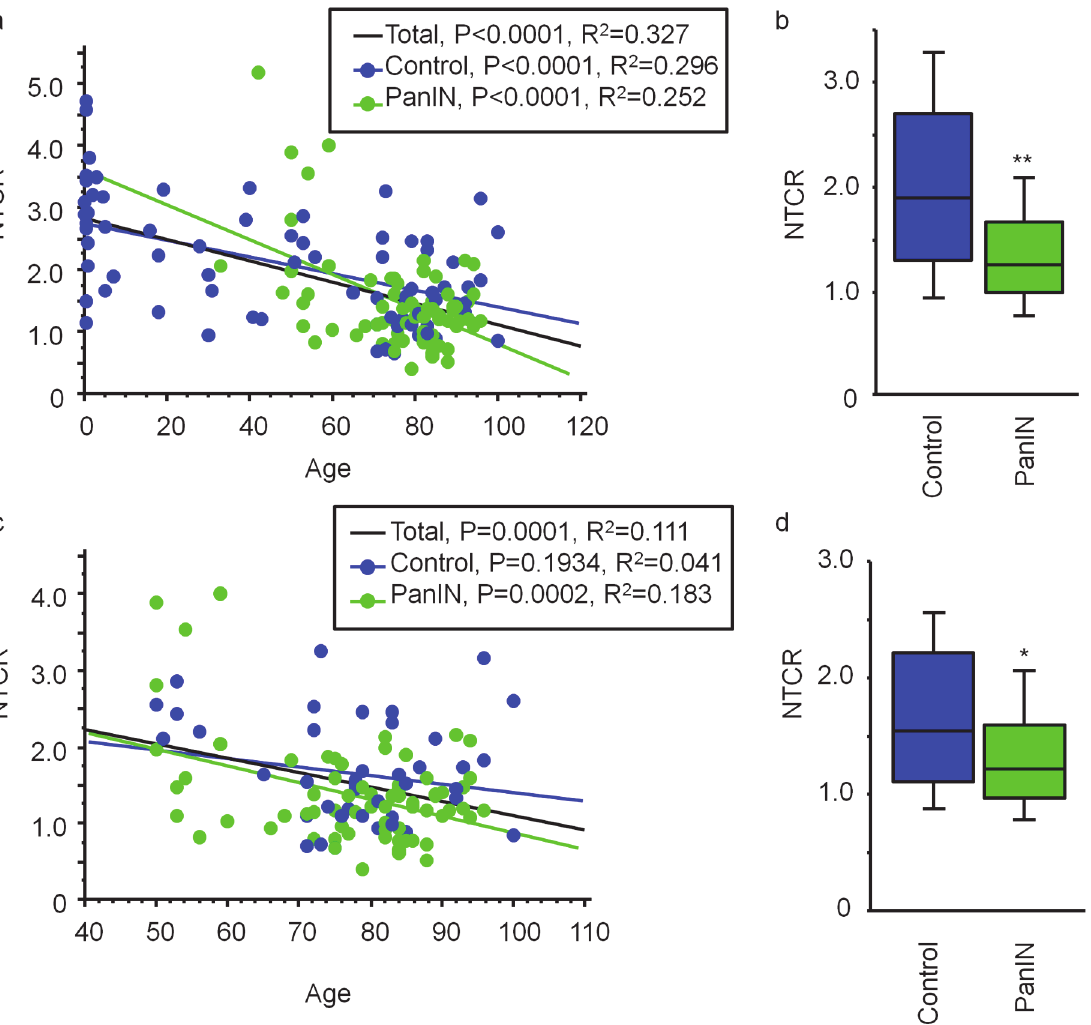
Fig 3. Telomere length in normal duct epithelium from autopsy cases. (a) NTCR in the normal duct epithelium in 150 autopsy cases was negatively correlated with age for the cases overall (n = 150, black), the control group (n = 77, blue) and the PanIN group (n = 73, green). (b) Comparison of NTCR in the normal duct epithelium between the control and PanIN groups. ** P < 0 . 01 vs control. (c) NTCR in normal duct epithelium from individuals aged over 50 years (n = 113). Blue, control (n = 43); green, PanIN group (n = 70). (d) Comparison of NTCR in the normal duct epithelium between the control and PanIN groups. * P < 0 . 05 vs